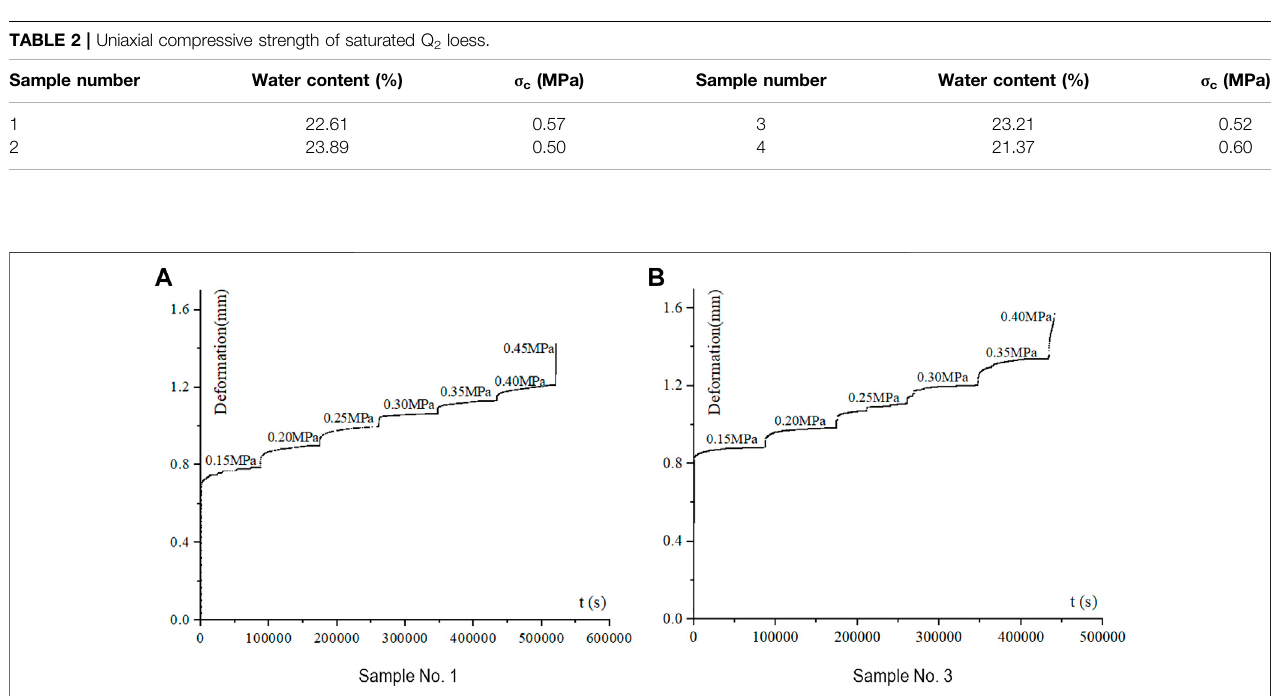
FIGURE 2 | Displacement vs. time from the creep tests of saturated Q 2 loess. (A) Sample No. 1. (B) Sample No. 3.